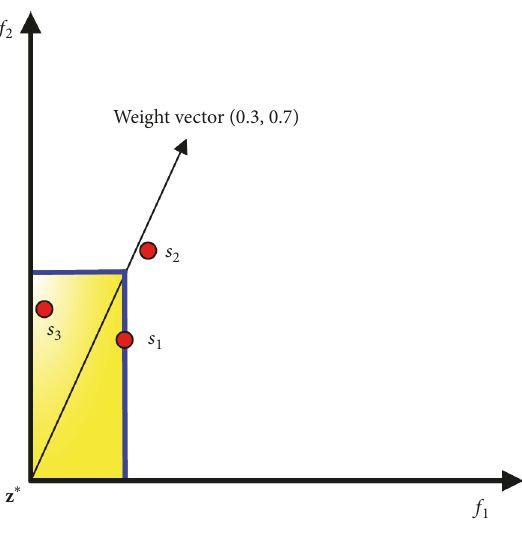
Figure 1: Update the subproblem by